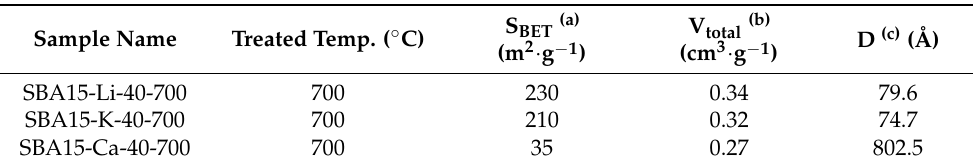
Table 3. Physico-chemical properties of the samples synthesized at 700 ◦ C with Li + , K + and Ca 2+ using Si/metal ion =